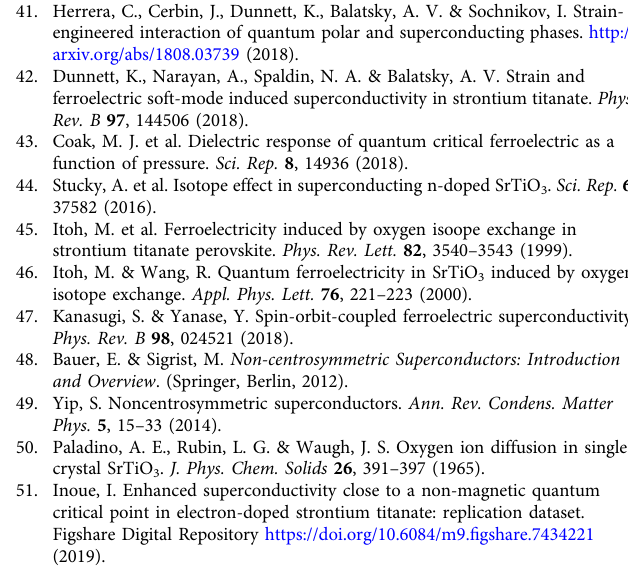
Figshare Digital Repository https://doi.org/10.6084/m9. fi gshare.7434221